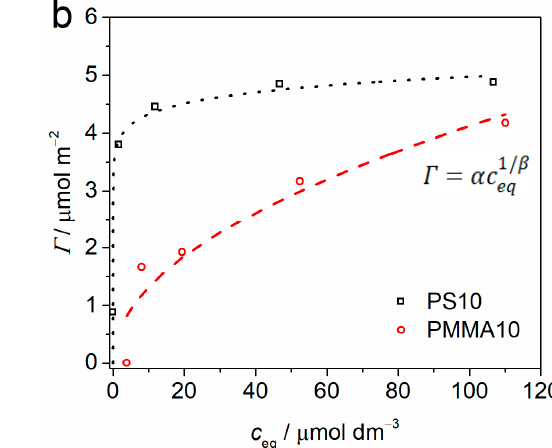
Figure 2. ( a ) Langmuir and ( b ) Freundlich adsorption isotherms for cypermethrin on 10 μ m poly- styrene (PS10) and polymethylmethacrylate (PMMA10) microparticles. Table 1. Langmuir (maximal surface concentration Γ max , adsorption constant K ad ) and Freundlich ( α , β ) adsorption isotherm parameters for microplastic-adsorbed cypermethrin.